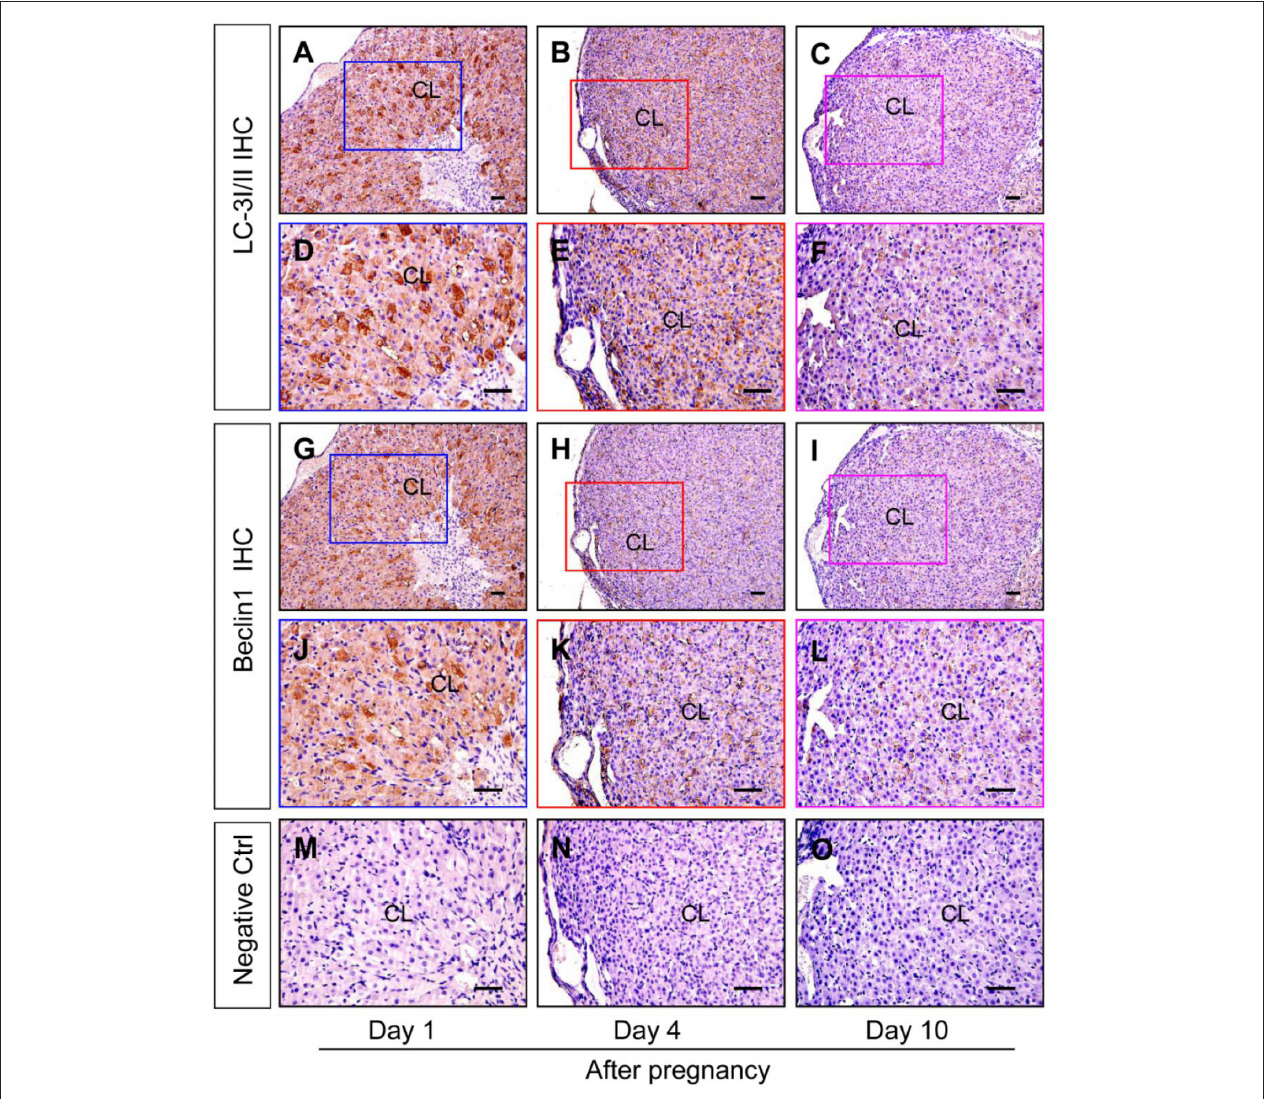
FIGURE 7 | Immunohistochemical staining of beclin1/LC-3I/II during the development of corpus luteum. Three time points (Day 1, 4, and 10 after pregnancy) were selected and represented as the developmental process of corpus luteum according to our previous reports. Ovarian sections of each point ( A,D,G,J,M for Day 1; B,E,H,K for Day 4; C,F,I,L,O for Day 10) were immunostained for beclin1/LC-3I/II and counterstained with hematoxylin. The beclin1/LC-3I/II immunohistochemical signals appear brown, and the background counterstaining appears blue ( A–F for LC-3I/II and G–L for Beclin1). Negative control remained unstained, lacking primary antibody instead of serum (M–O) . CL, corpus luteum, bar = 100 µ